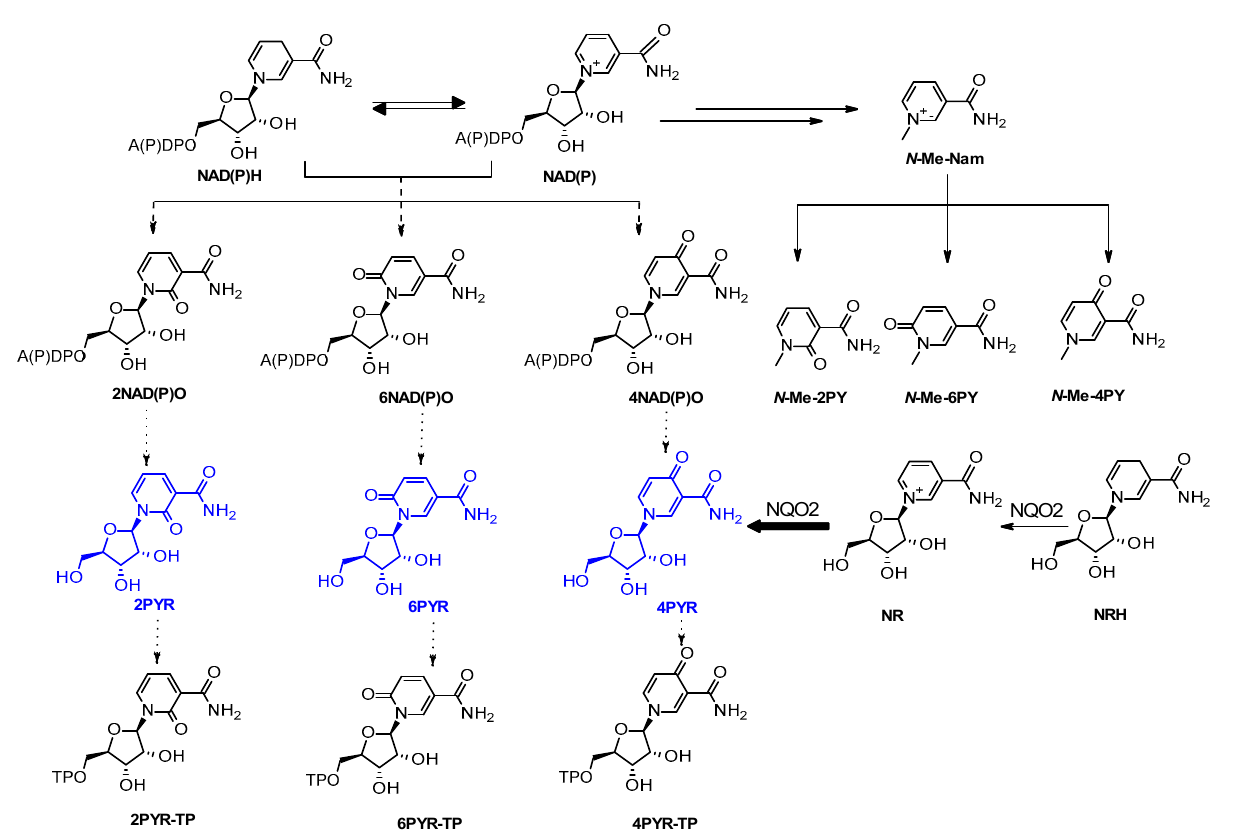
Figure 1. NAD(P)(H)-derived pyridone catabolites. An additional route to the triphosphate from the monophosphate ribosylated pyridone generated from the dinucleotides can also be envisaged. NAD(P)(H): nicotinamide adenine dinu- cleotide (phosphate)(reduced form); NAD(P)O: hyper- oxidized forms of NAD(P) containing pyridone moieties; PYR-TP: pyridone riboside triphosphate; PYR: pyridone riboside; The 2, 4, and 6 positions of the carbonyl unit are indicated in the abbreviation; N -Me-PY: N -methyl pyridone.